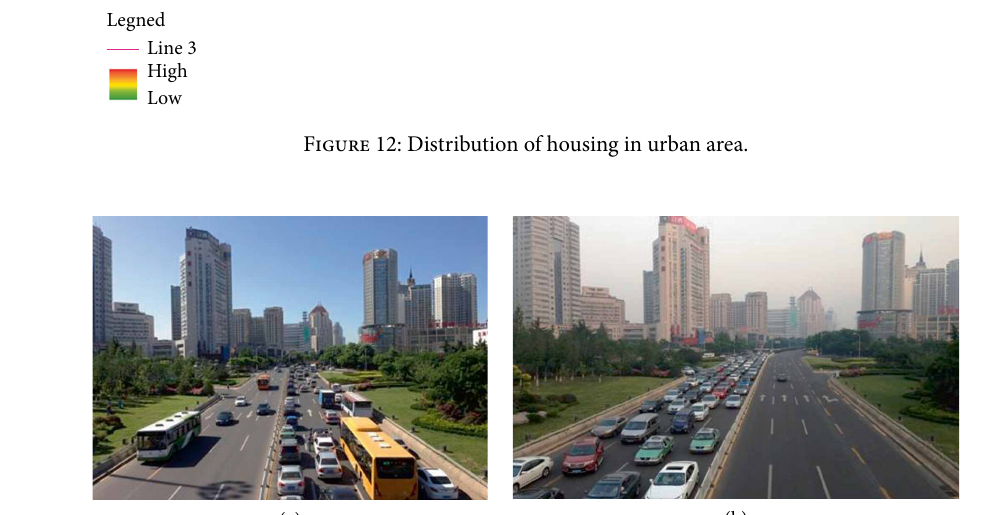
Figure 13: Tidal Traffic of Shandong road. (a) Morning peak on Shandong road, (b) evening peak on Shandong